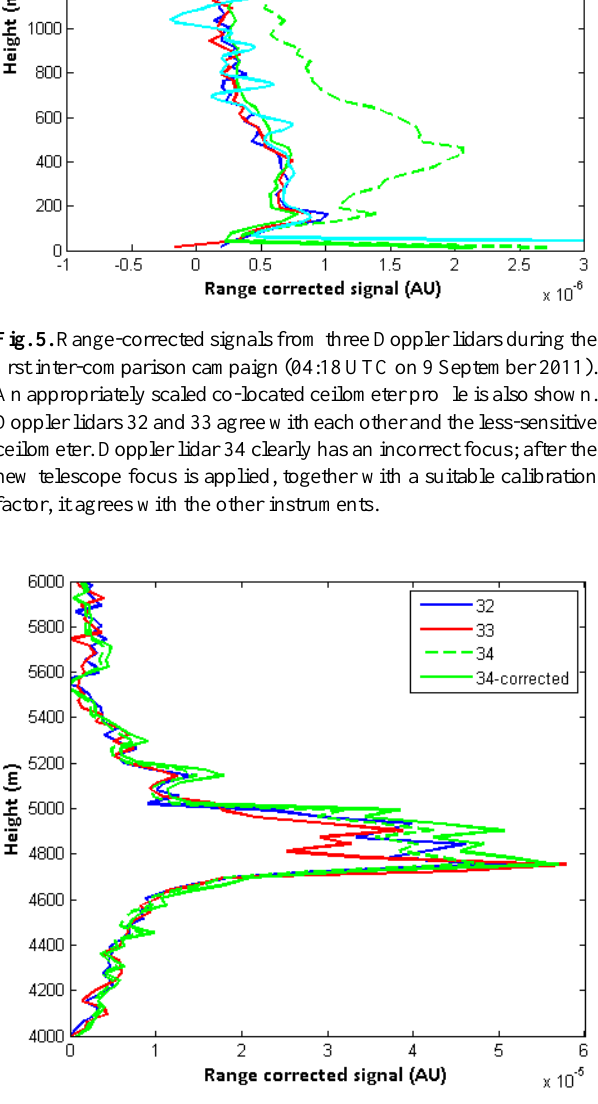
Fig. 6. As Fig. 5, except that the instrument range has been selected to encompass ranges at which cirrus may be present. Note that the co-located ceilometer was not sensitive enough to detect this partic- ular cirrus cloud.